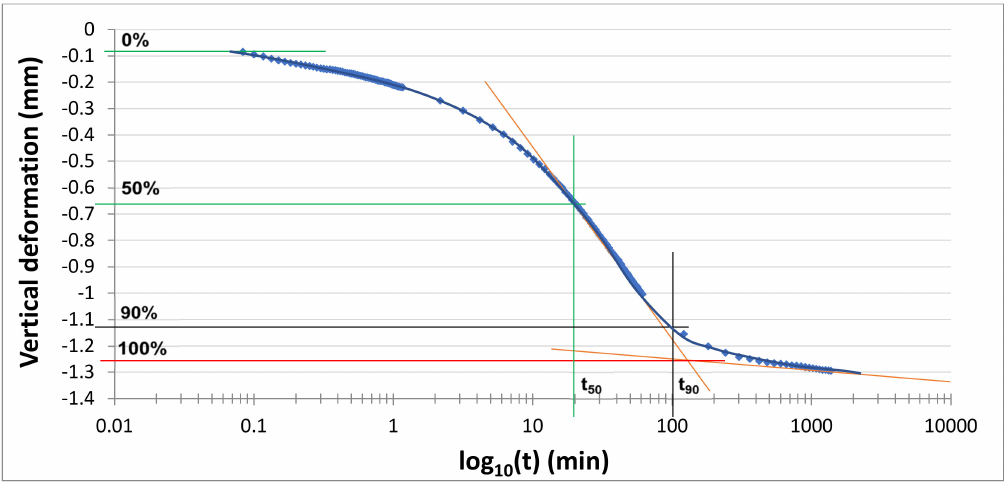
Figure 6. Consolidation curve of loading step 3 (high content muscovite soil).